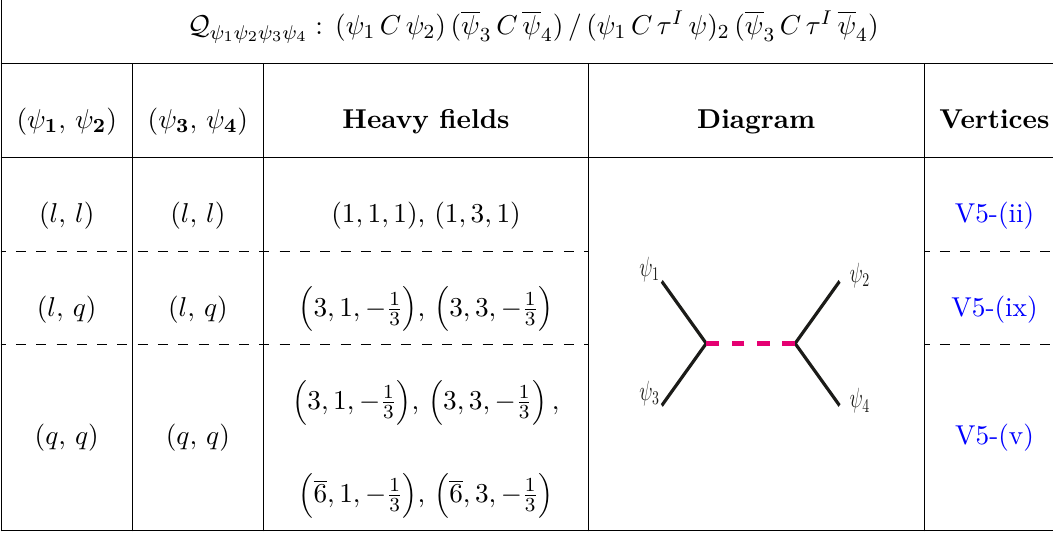
Table 13 . Heavy field representations that are obtained by unfolding the ψ 4 operators, composed of the left chiral SM fermions q and l , into a tree-level diagram yielding non-zero contributions and the corresponding vertices that constitute the diagram for individual cases. The operators have different fermions as external legs but they unfold through similar diagrams. The table header schematically describes the covariant forms of the